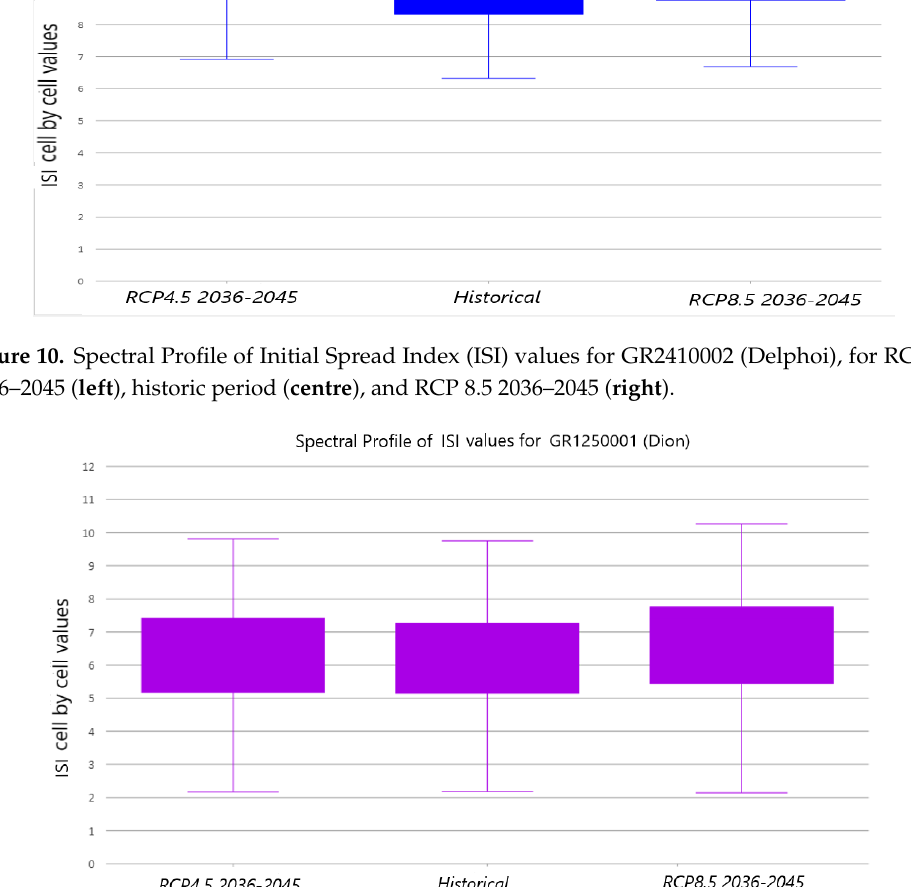
Figure 11. Spectral Profile of Initial Spread Index (ISI) values for: GR1250001 (Dion), for RCP 4.5 2036– 2045 ( left ), historic period ( centre ), and RCP 8.5 2036–2045 ( right ).